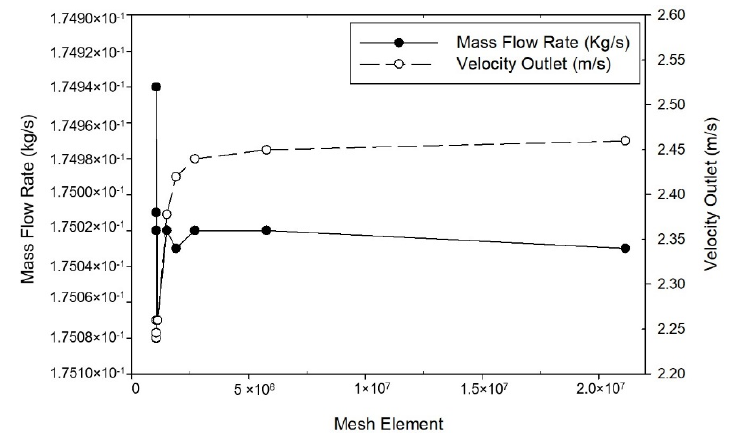
Figure 3. Grid independence test based on mass flow rate and velocity